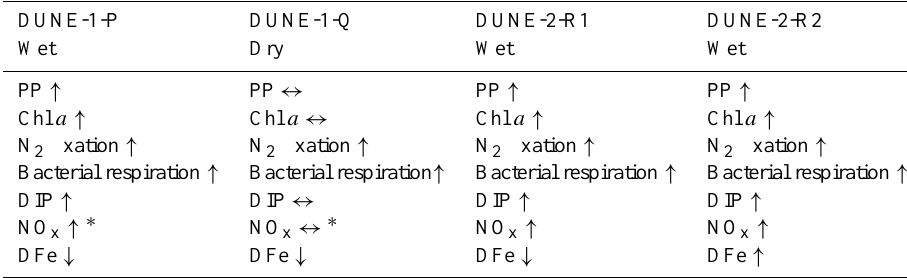
Table 3. Summary of the biological and chemical changes observed after the DUNE seedings in the Dust-meso relative to the Control-meso. Results from: this study; Ridame et al. (2013); Pulido-Villena et al. (2010, 2014); Pulido-Villena, personal communication (2013); Wagener et al. (2010); T. Wagener, personal communication, 2013; and Wuttig et al. (2013).